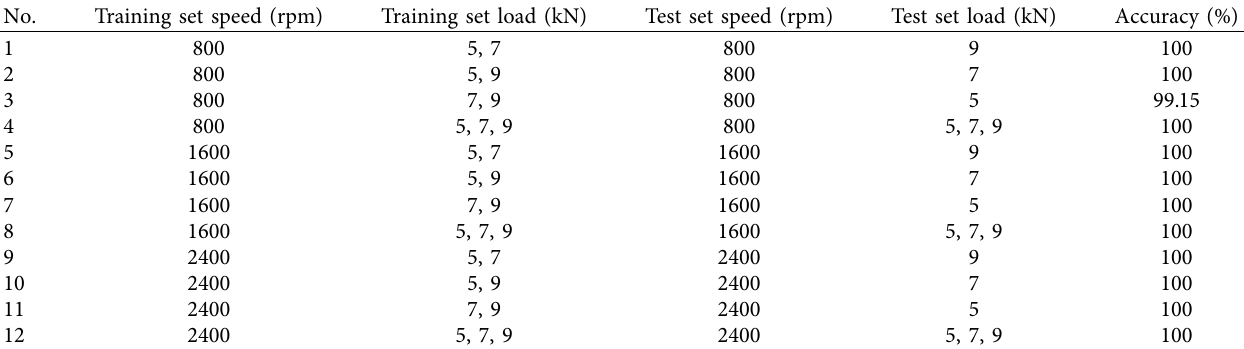
Table 5: Fault diagnosis accuracy of variable load at the same speed.